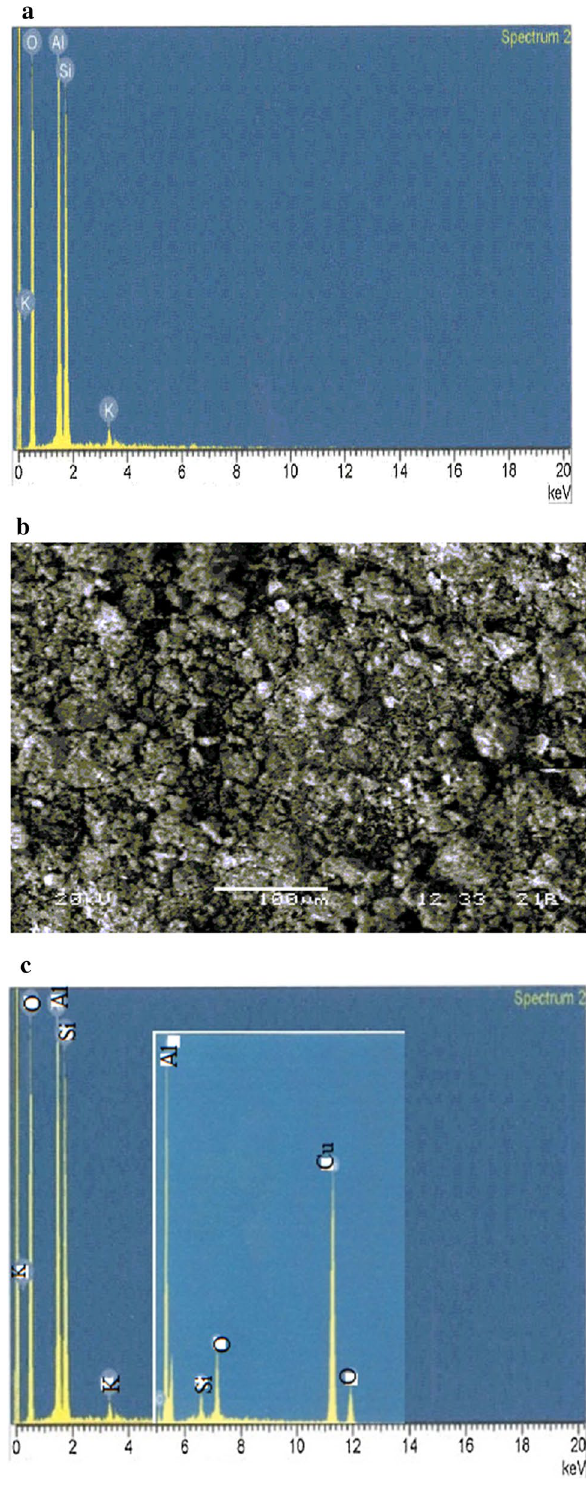
Fig. 2 a EDS for kaolinite showing element peaks (Egirani et al. 2017a), b SEM for CuO–kaolinite composite showing particle sizes (Egirani et al. 2017a), c EDS for CuO–kaolinite composite showing element